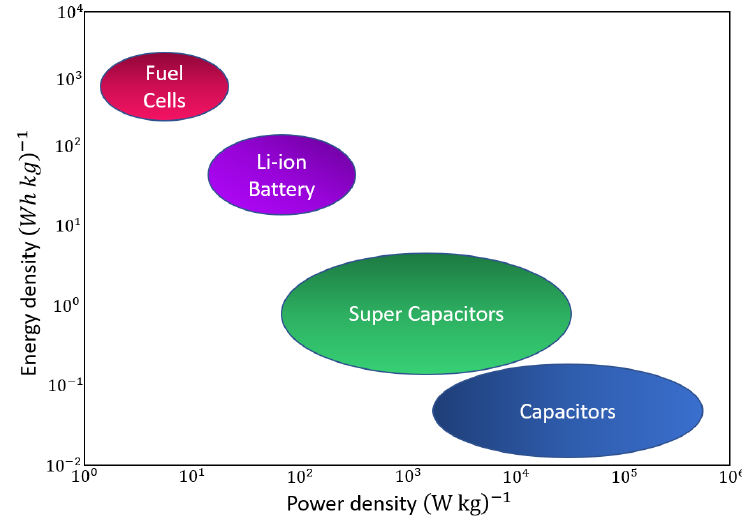
Figure 1. Ragone plot showing the power density vs. the energy density relative to present-day